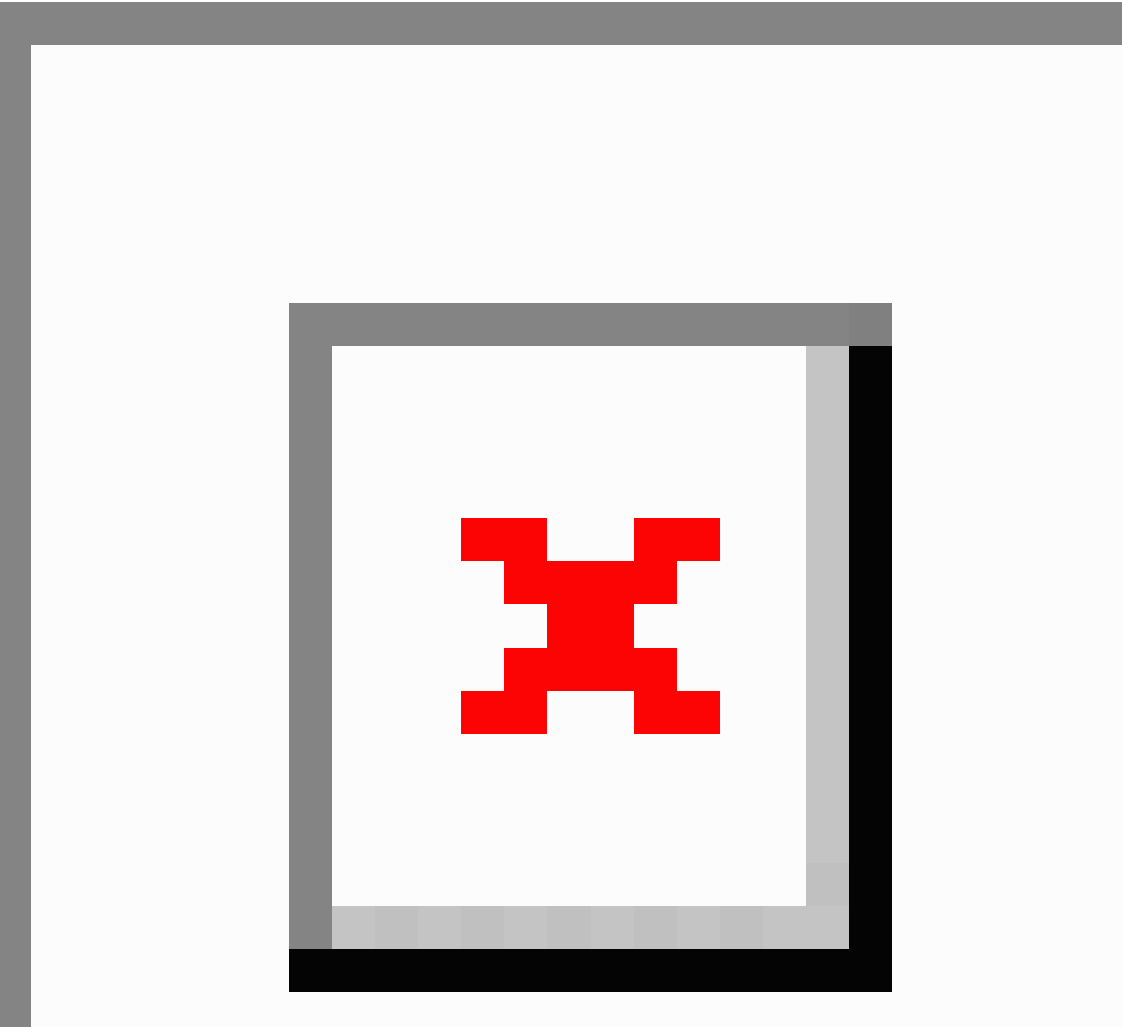
Figure 5. Cost-effectiveness acceptability curve of the New York Health Association functional class scenario analyses. CEAC: cost-effectiveness acceptability curve; NYHA: New York Health